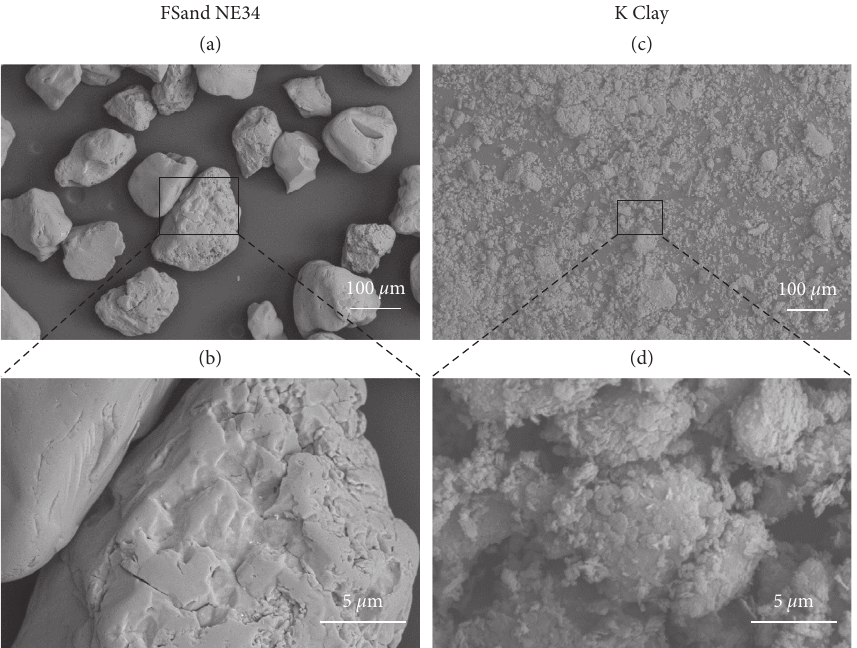
Figure 1: Secondary electron (SE) images under SEM of (a) low magnification view of FSand NE34; (b) high magnification view of FSand NE34; (c) low magnification view of K Clay; (d) high magnification view of aggregates in K Clay.